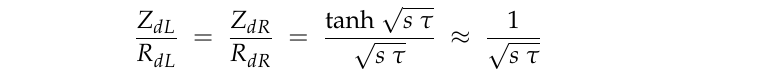
Figure 4. Bode-type plot of the imaginary part of the impedance of ion-exchange membrane systems for I DC / I L = 0, 0.25 and 0.5. The arrow indicates increasing values of I DC .